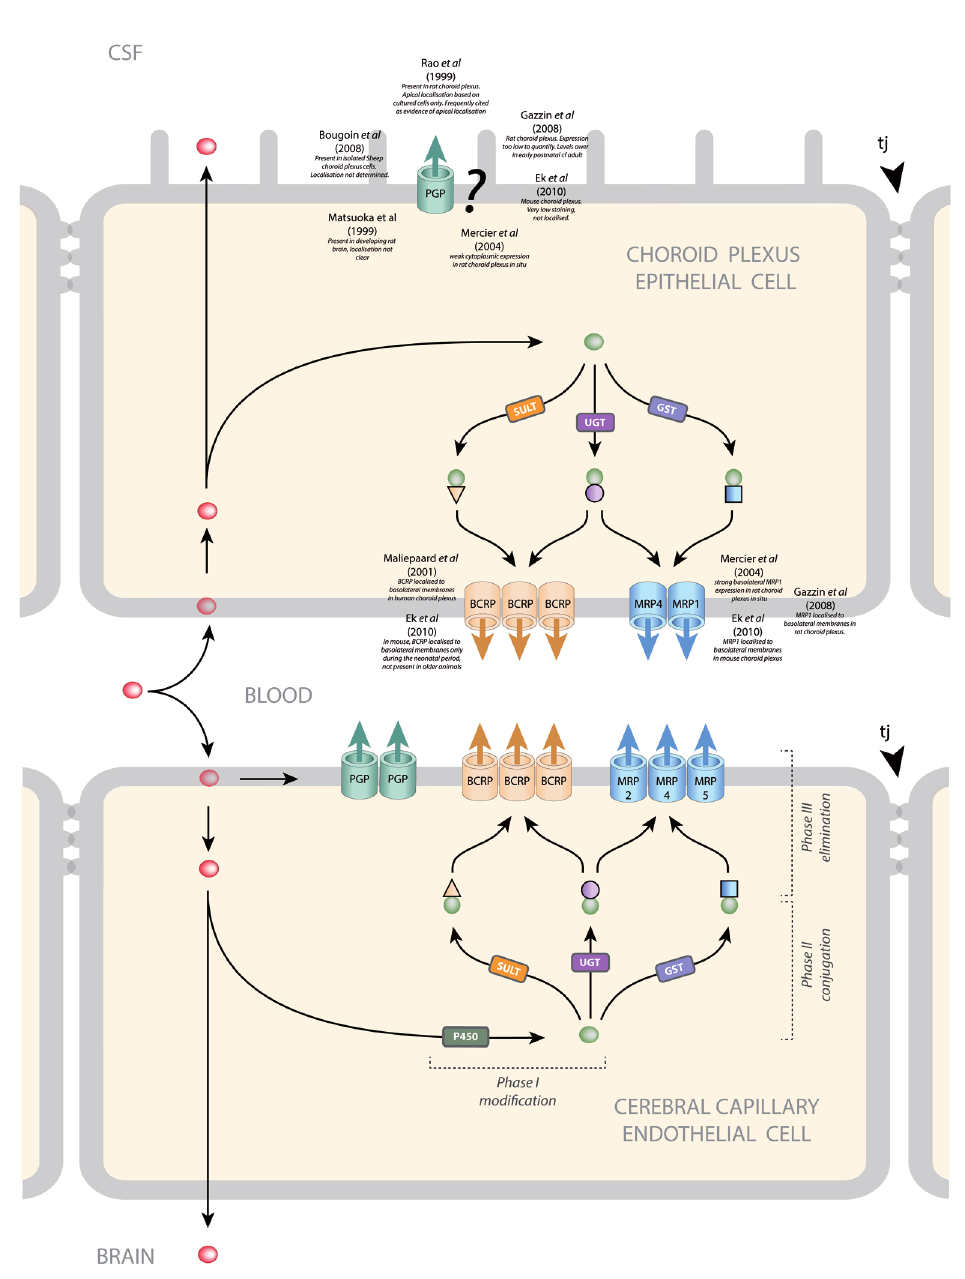
Figure 5. Efflux pathways in barrier-forming cells. The main efflux transporters at the blood-brain and blood-CSF interfaces are P-glycoprotein (PGP, MDR1, ABCB1), breast cancer resistance protein (BCRP, ABCG2), and several members of the multidrug resistance protein subfamily (MRP1 ABCC1, MRP2 ABCC2, MRP4 ABCC4, MRP5 ABCC5). In cerebral capillary endothelial cells (blood-brain barrier), PGP 41–43 , BCRP 44,45 , MRP2 46 , MRP4 46 , and MRP5 47 are localized to the luminal membrane where they export compounds into the blood. In choroid plexus epithelial cells (blood-CSF barrier), MRP1, MRP4, and BCRP are localized to the basolateral membranes where they export compounds into the stroma of the plexus 40,48,49 . The subcellular localization of PGP in choroid plexus is not clear. Some studies